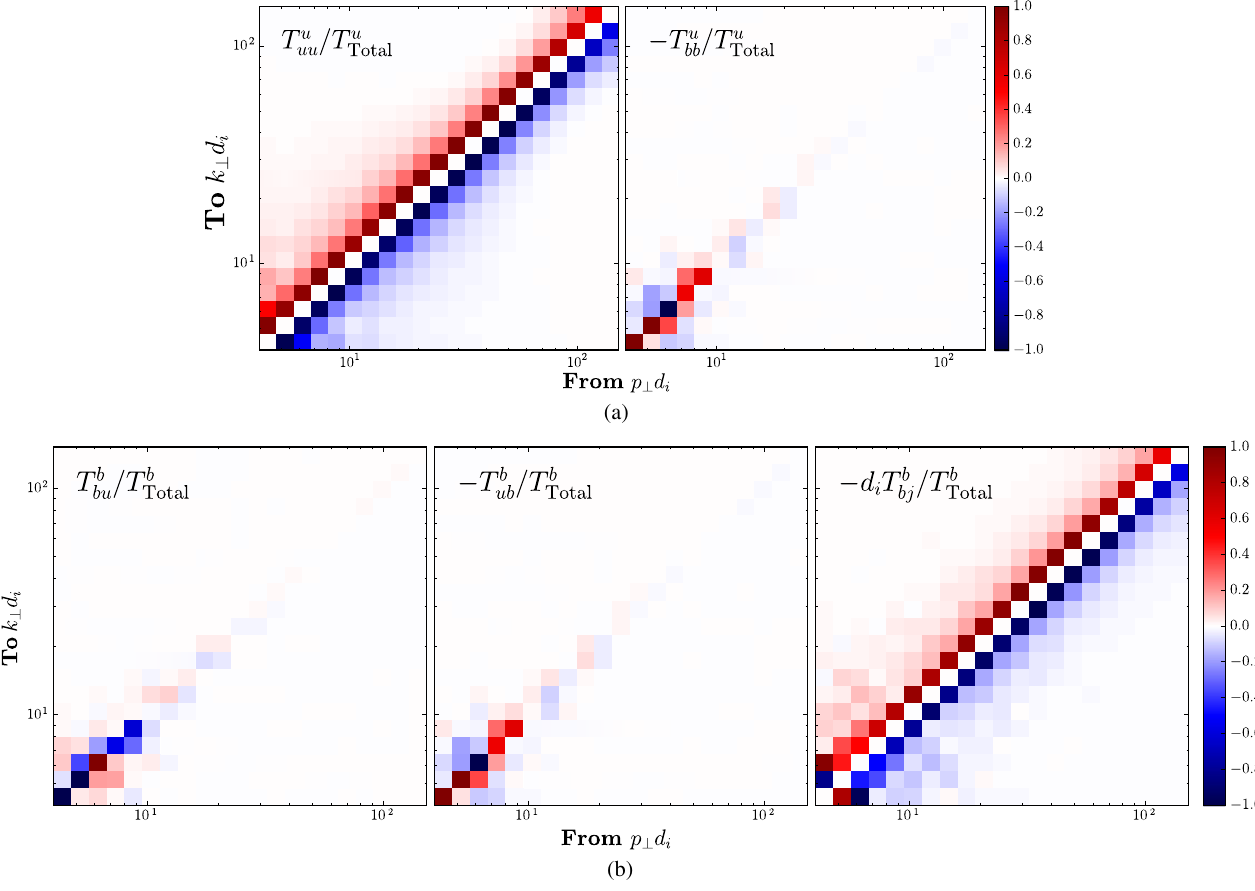
FIG. 7. Normalized transfer functions for the kinetic energy (top) and magnetic energy (bottom) for run